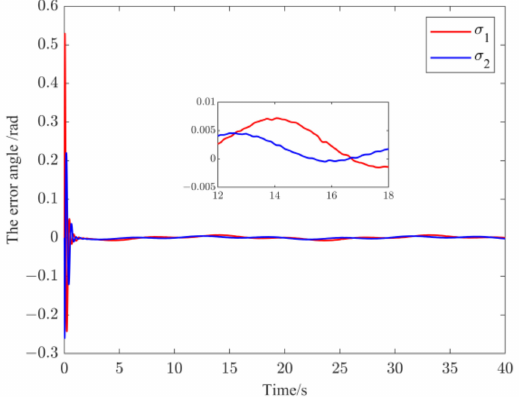
Figure 6. The angle error σ .